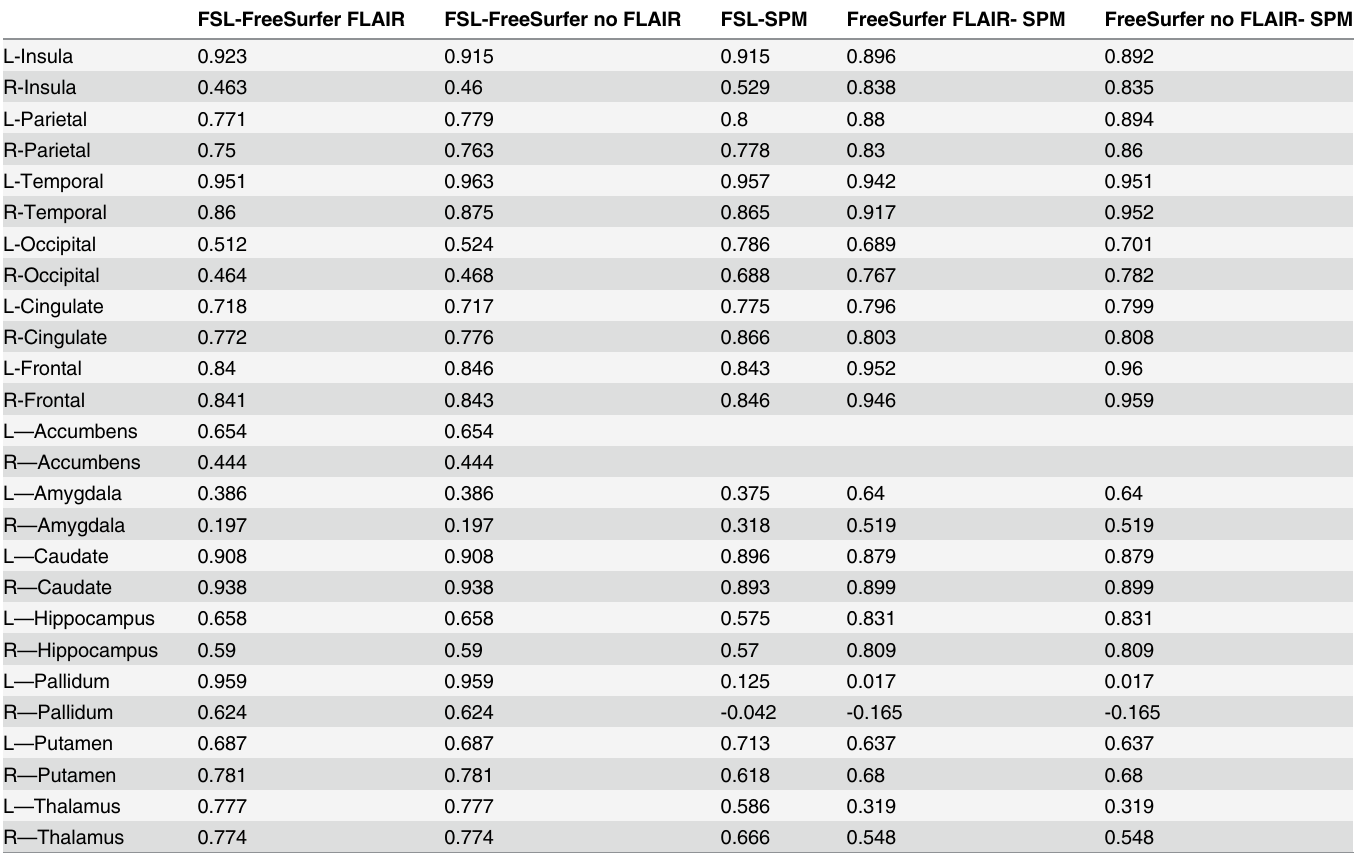
Table 4. Intraclass Correlation Coefficient